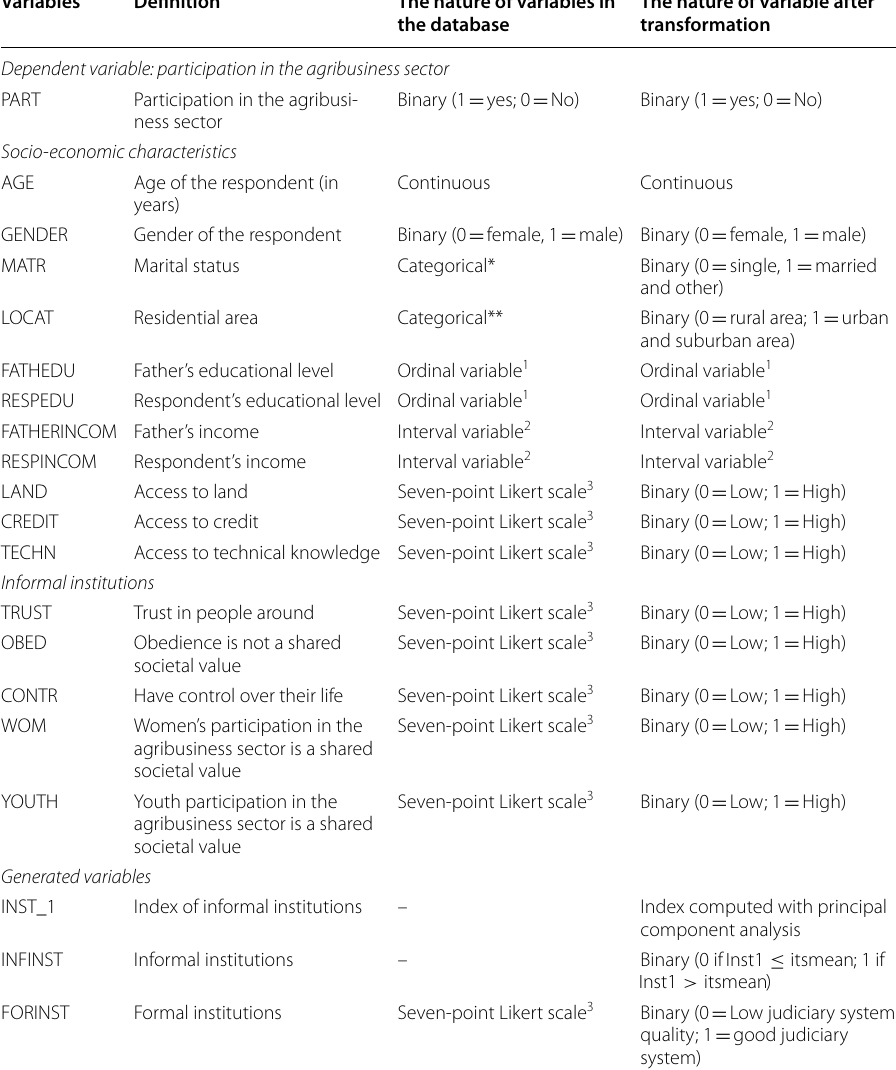
Table 1 Definition of variables. Source : authors,